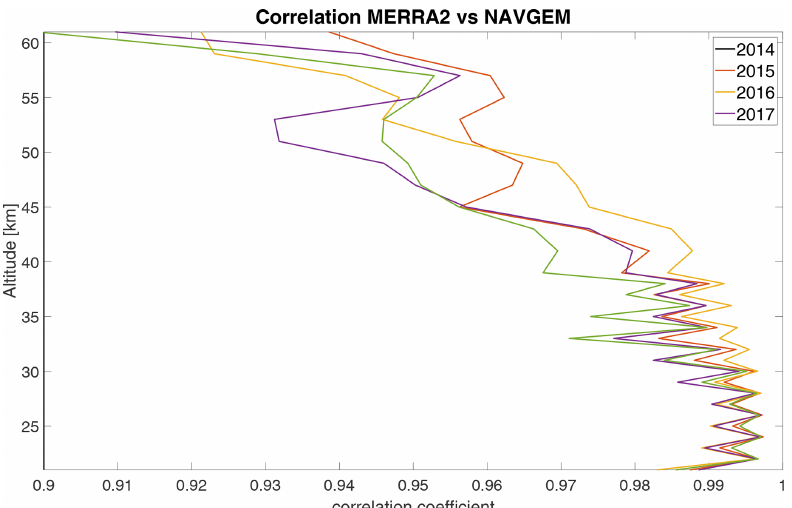
Figure B2. Correlation coefficients between the MERRA2 and NAVGEM-HA datasets. Correlation coefficients over all altitudes are above